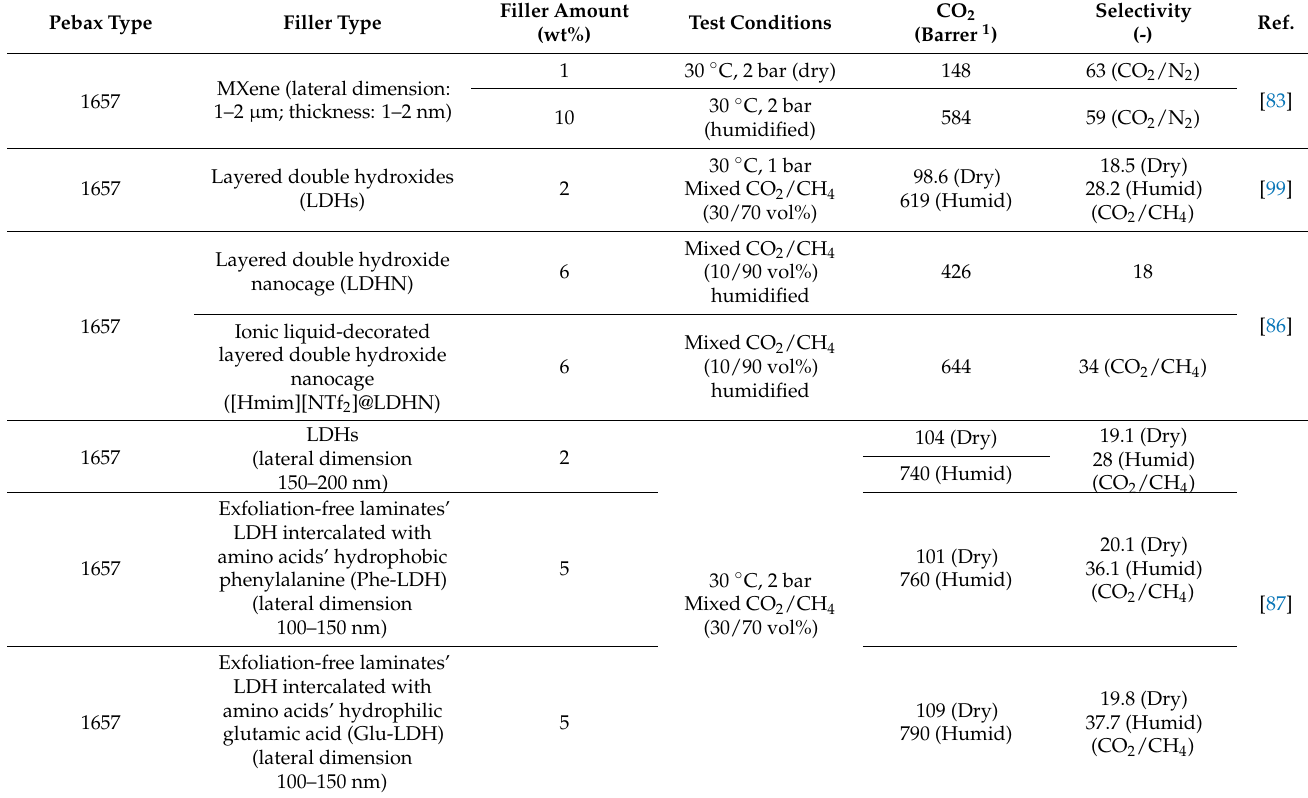
Table 8. Permeation properties of selected Pebax-based MMMs filled with nanosheets.